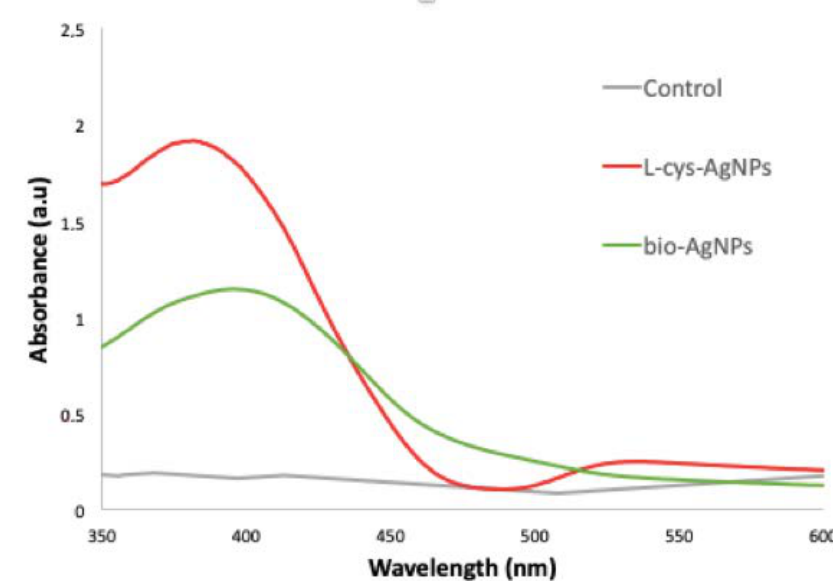
Figure 1. UV − Vis spectrum of the L -Cys-AgNPs (red), the bio-AgNPs (green), and the control AgNO 3 (grey). Table 1. Size and Z Potential analysis of L -Cys-AgNPs and bio-AgNPs after 12 h of synthesis.